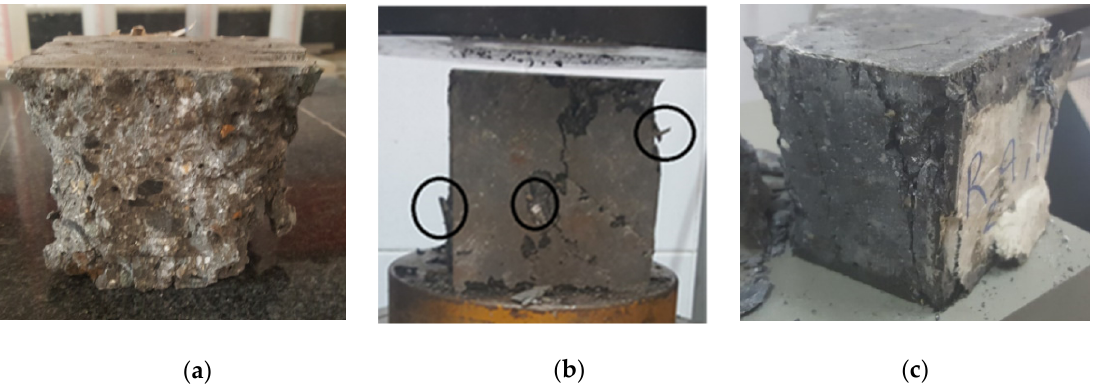
Figure 7. The failure modes of the ( a ) control, ( b ) RCA-NS, and ( c ) RCA-UNS samples.